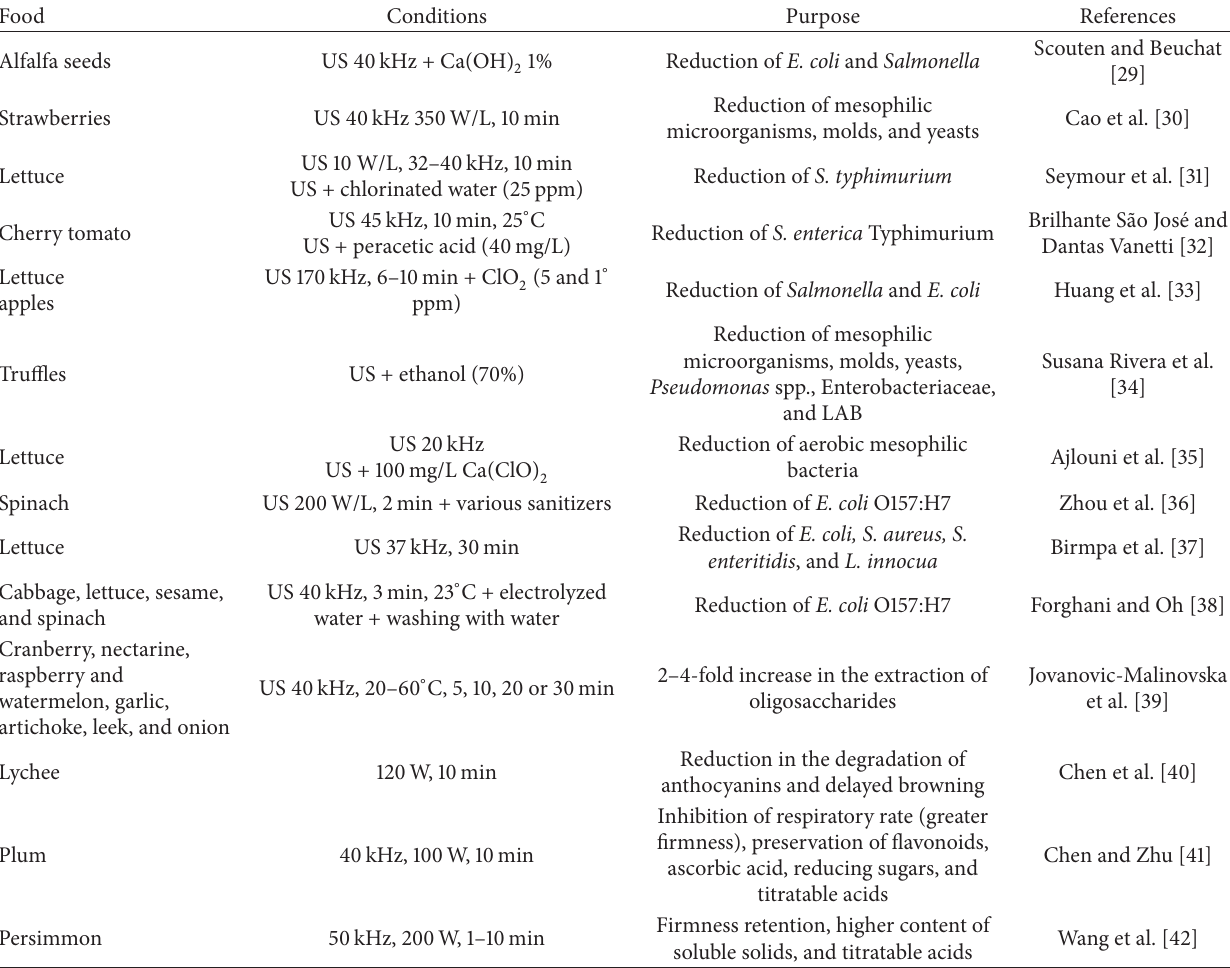
Table 4: Application of ultrasound in fruits and vegetables for various